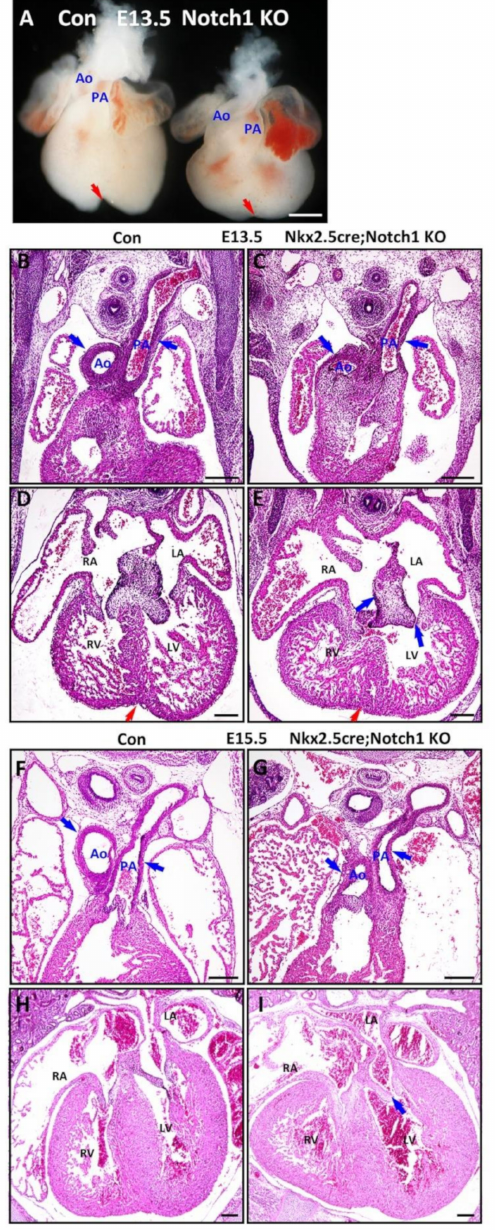
Figure 3. Notch1 is required for outflow tract clockwise rotation and septation. ( A – E ) The myocar- dial Notch1 knockout hearts via Nkx2.5 Cre/+ are relatively smaller and display abnormal